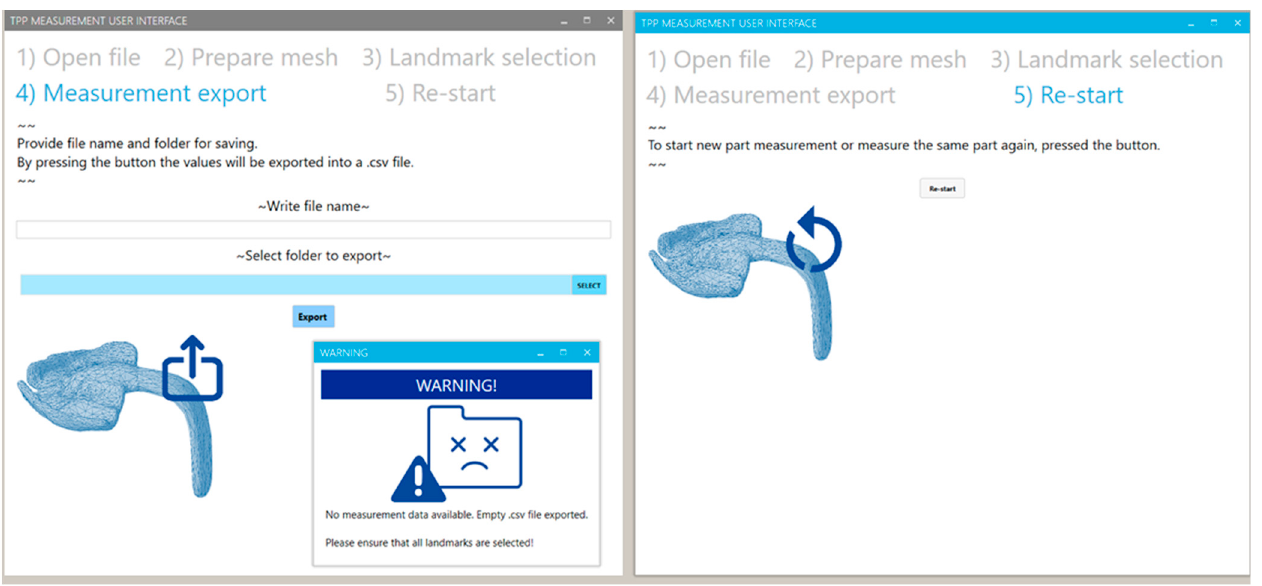
Figure 15. User interface view for the “landmark selection” and “selection control panel” for the completeness control of the process.